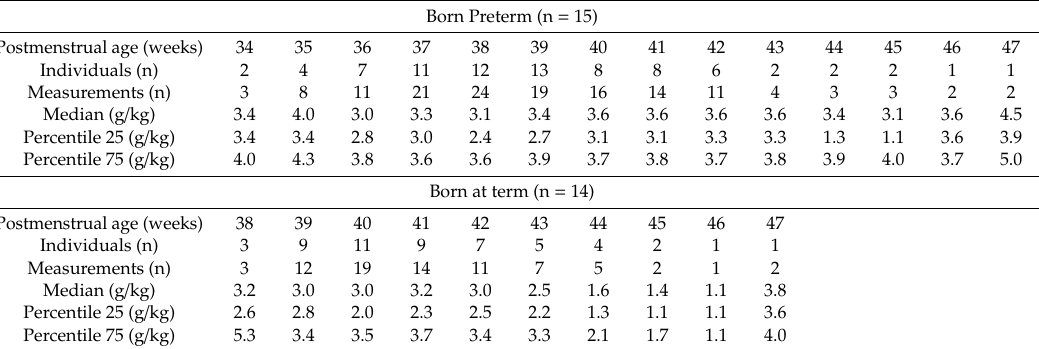
Table 2. Daily protein intake in infants born preterm and at term.